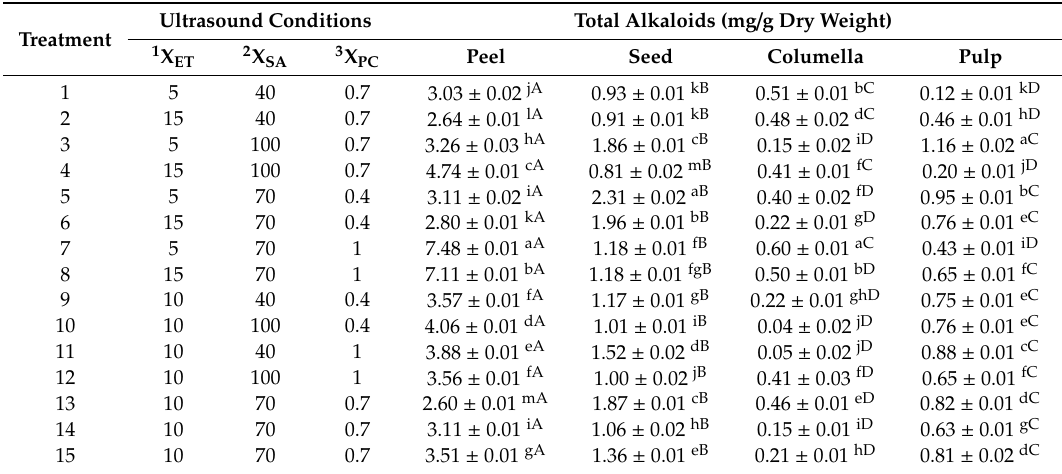
Table 1. E ff ect of the variables of the process of extraction assisted with ultrasound on the content of total alkaloids from A. muricata peel, seed, columella, and